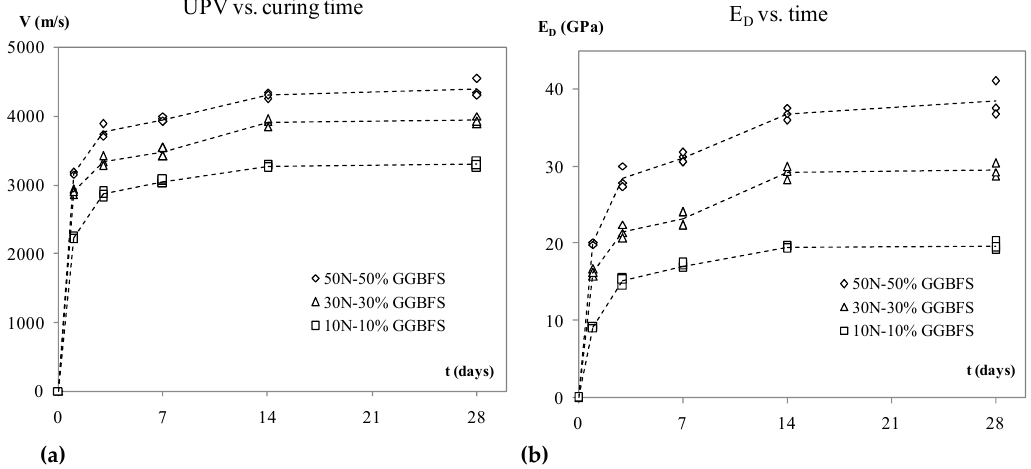
Figure 4. The f t (f c ) relationships for fly-ash geopolymer mortars 10N, 30N, and 50N, compared with the ACI 318-02 square root equation for geopolymer binders.